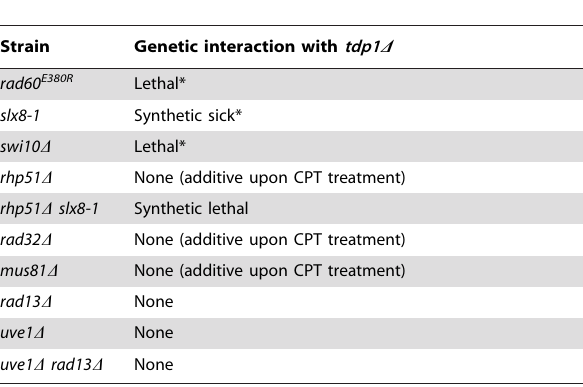
Figure 4. The Rad60:Ubc9 complex and the Nse2 SUMO E3 ligase are essential to protect tdp1 D cells from Top1-induced DNA damage. (A) A representative tetrad dissection is shown from